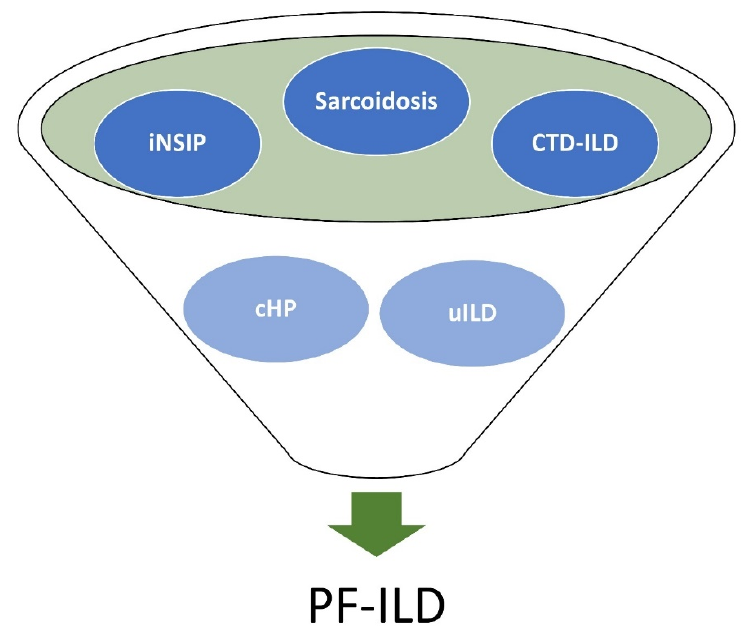
Figure 1. Examples of underlying etiologies in patients with PF-ILD.